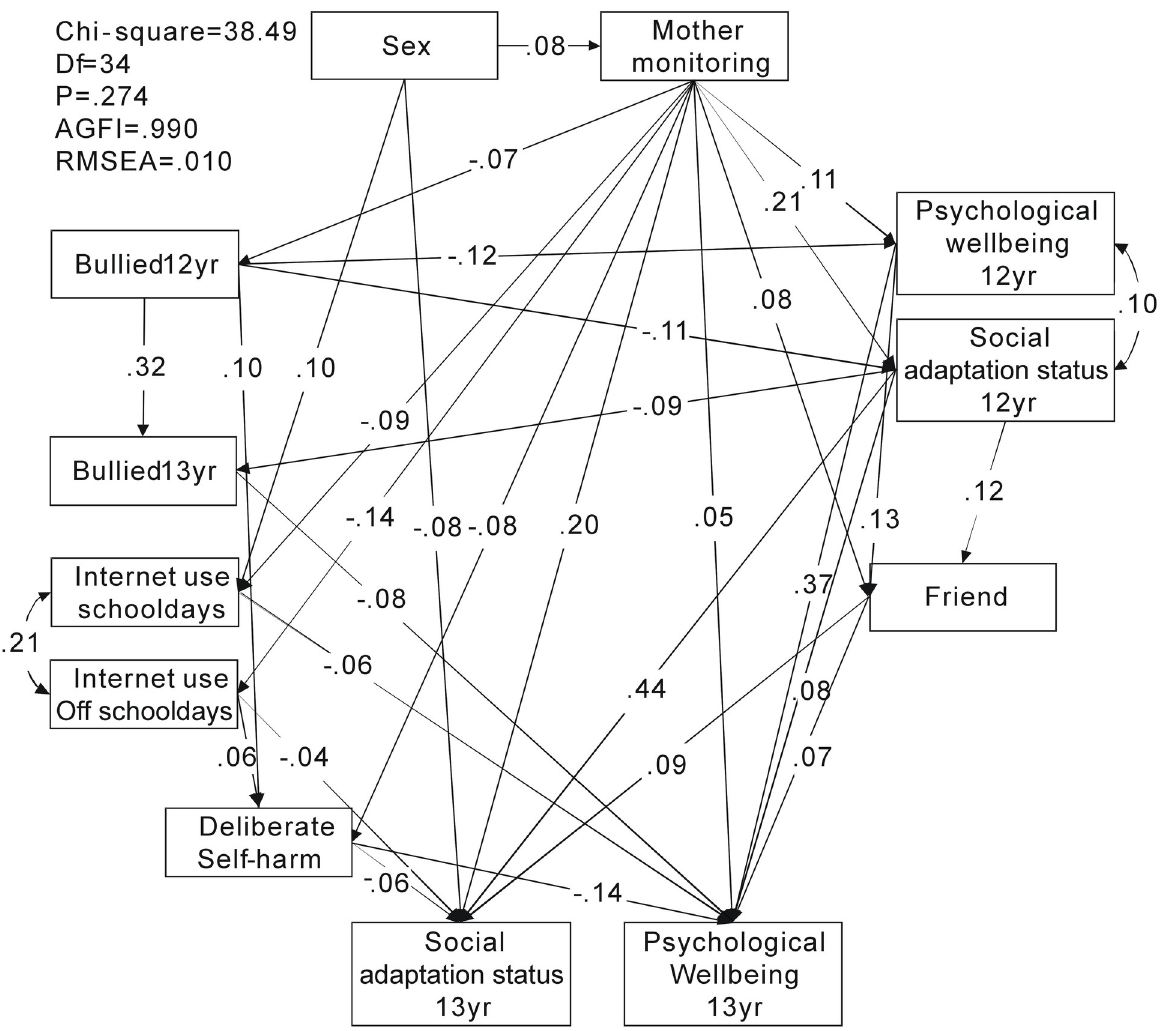
Fig 1. Pathway relationships among maternal monitoring, bullying, internet use, deliberate self-harm and self-perceived happiness. AGFI: adjusted goodness-of-fit; RMSEA: root mean square error of approximation being bullied at age 12 years, and spending more time online during days off school were asso- ciated with increased likelihood of deliberate self-harm ( β = − 0.08, p = 0.002; β = 0.10, p < 0.001; β = 0.06, p = 0.036). Finally, factors associated with the SAS of adolescents at age 13 years included deliberate self-harm, sex, mother monitoring, level of happiness at age 12 years, and interaction with friends. Those who perceived more maternal monitoring, had more frequent interaction with friends, and perceived a higher level of happiness at age 12 had a higher level of happiness at age 13 years (maternal monitoring: β = 0.20, p < 0.001; β = 0.05, p = 0.034; interaction with friends: β = 0.09, p < 0.001; β = 0.07, p = 0.003; SAS at 12 years: β = 0.44, p < 0.001; PWB at 12 years: β = 0.37, p < 0.001; β = 0.08, p = 0.002). In contrast, those who deliberately harmed themselves had a lower level of happiness (SAS: β = − 0.06, p = 0.007; PWB: β = − 0.14, p < 0.001). Furthermore, adolescents who spent more time online during schooldays had a lower PWB ( β = − 0.06, p = 0.012); however, those who spent more time online during days off school had a lower SAS ( β = − 0.04, p = 0.047).